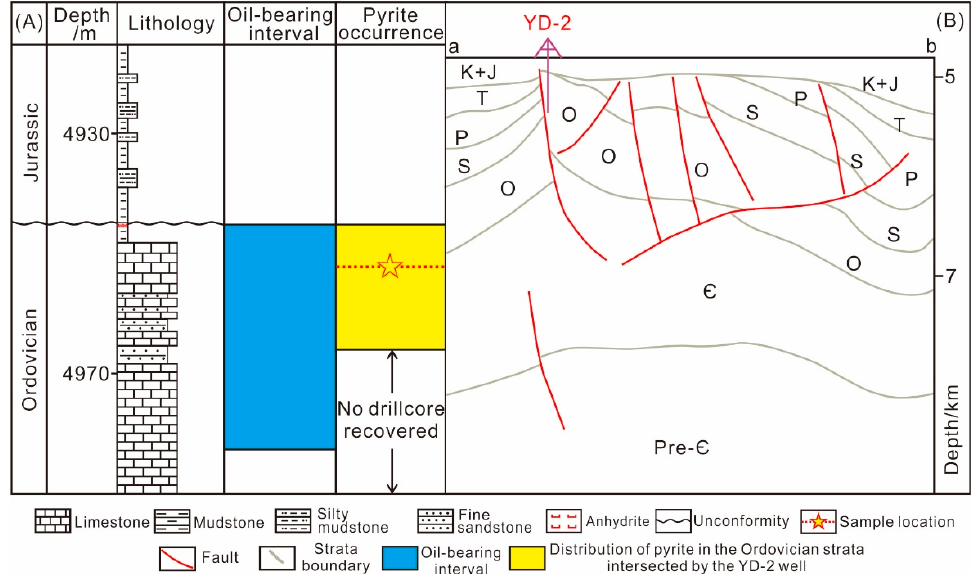
Figure 2. ( A ): In YD-2, the Ordovician strata are directly overlain by Jurassic strata. Limited amounts of heavy oil have been obtained from the Ordovician strata (4945 m and 4983.5 m) in YD-2. Pyrite is commonly disseminated in the oil-bearing interval [22]. ( B ): Nearby faults can be significant conduits for the migration of both hydrocarbons and hydrothermal fluids that are necessary for the precipitation of pyrite in the Ordovician reservoir of the YD-2 well. The location of the cross-section is shown in Figure 1. Є— Cambrian; O—Ordovician; S—Silurian; P—Permian; T—Triassic; J—Jurassic; K—Cretaceous.